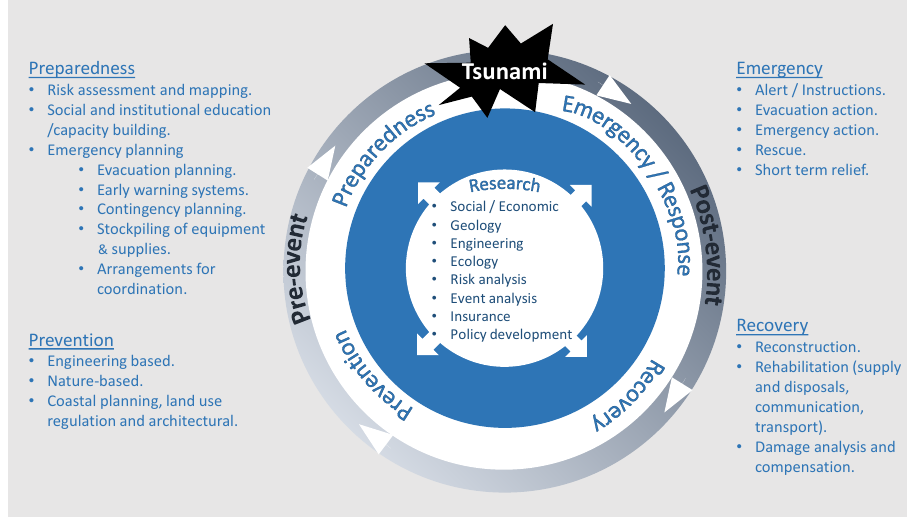
Figure 2. Disaster risk management